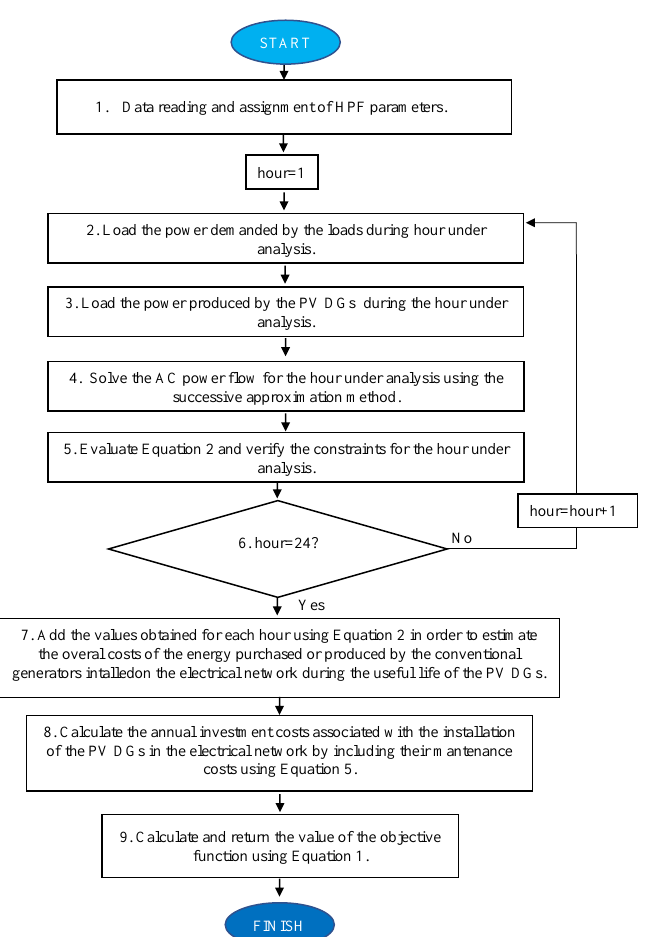
Figure 4. Hourly power flow proposed to evaluate the objective function in the DCPPSO